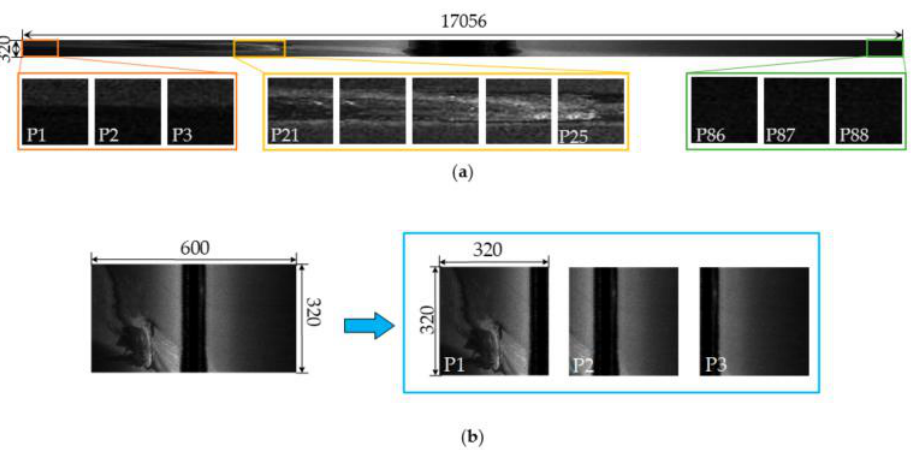
Figure 20. SSS image sampling: ( a ) patches of raw SSS image; ( b ) patches of SSS image sampled in